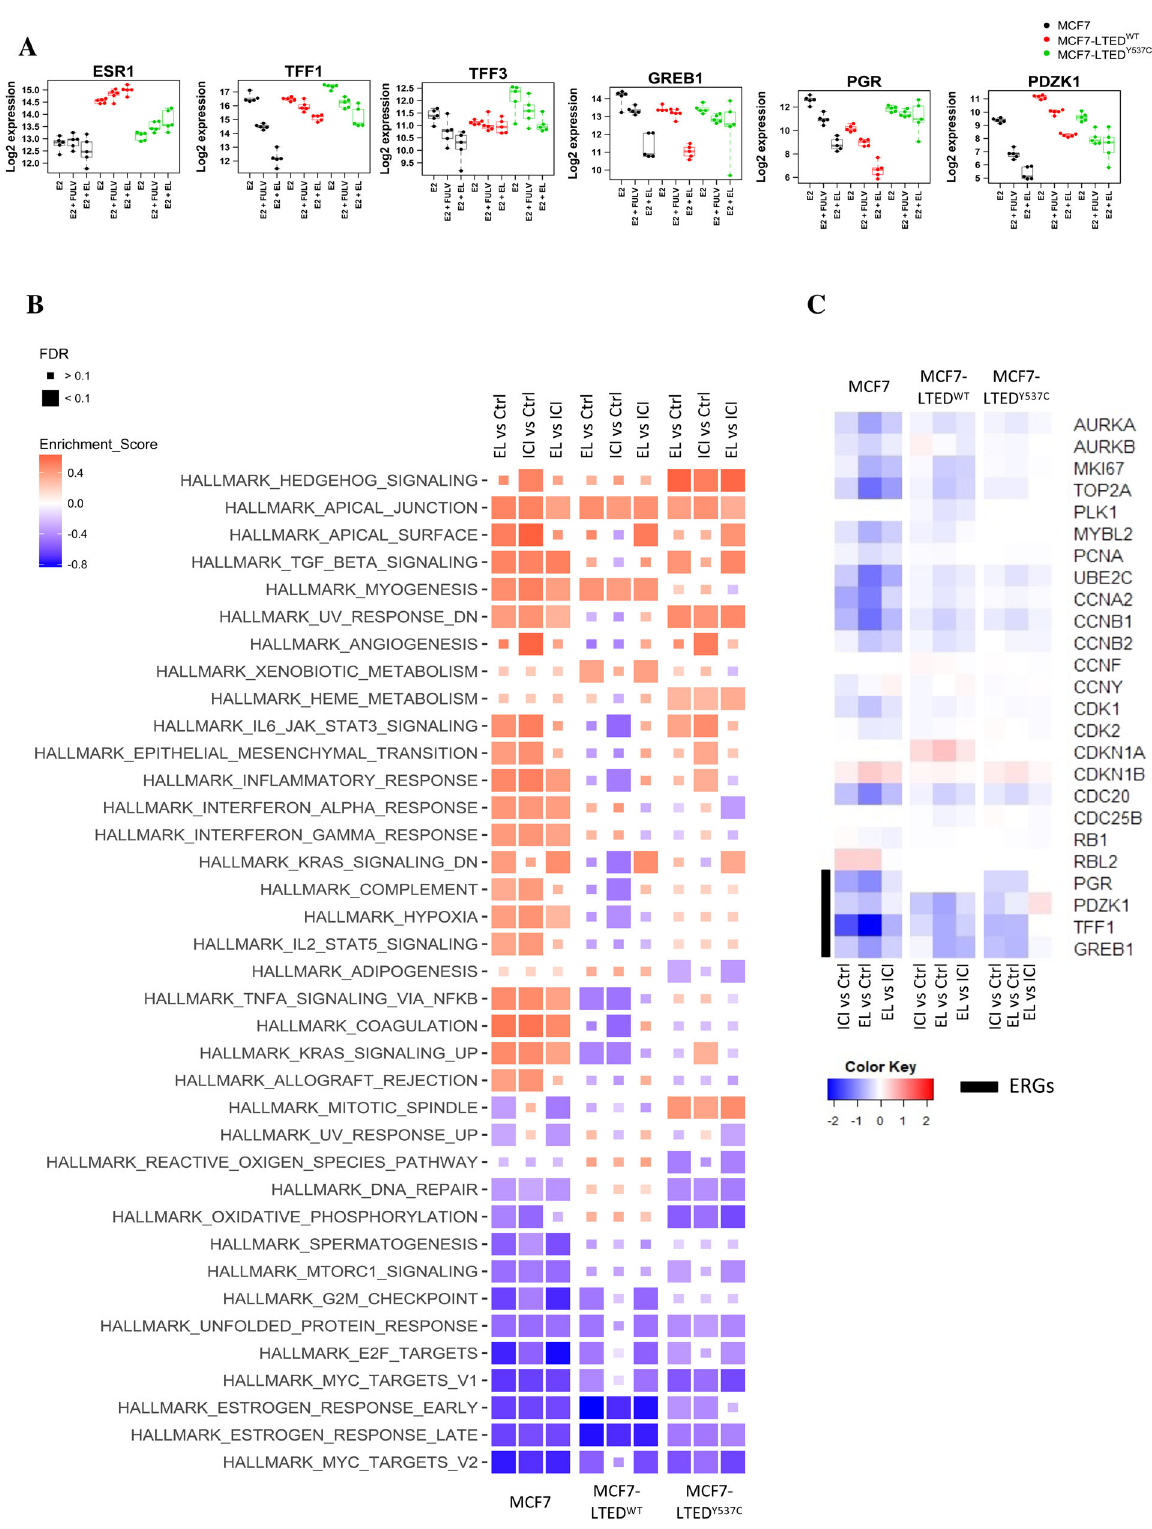
Fig. 3 Effect of elacestrant versus fulvestrant on ER-mediated transcription and translation. A Log2 expression of E-regulated genes together with ESR1 in MCF7 and both MCF7-LTED cell lines after treatment with 10 nM fulvestrant or 100 nM elacestrant. All treatments were performed in the presence of 1 nM E2. B Heatmap displaying changes in hallmark pathways following treatment with 10 nM fulvestrant (FULV) or 100 nM elacestrant (EL) in MCF7, MCF7-LTED wt and MCF7-LTED Y537C . C Effect of 100 nM elacestrant and 10 nM fulvestrant upon protein abundance of cell cycle markers and E-regulated proteins in MCF7, MCF7-LTED wt and MCF7-LTED Y537C . (Data from n = 5 biological experiments, per treatment per cell line). Published in partnership with the Breast Cancer Research Foundation npj Breast Cancer (2022)